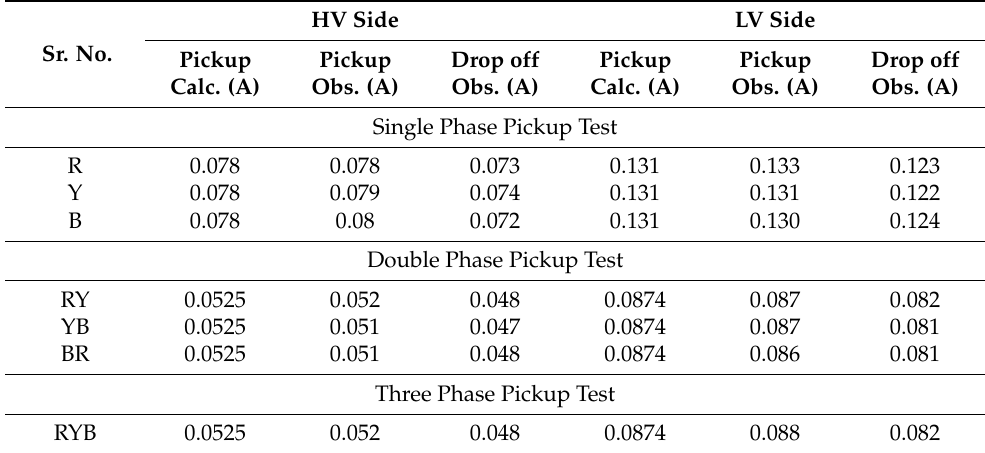
Table 7. Single, double, and three phase pickup and drop-off test of differential relay. HV Sr. No.